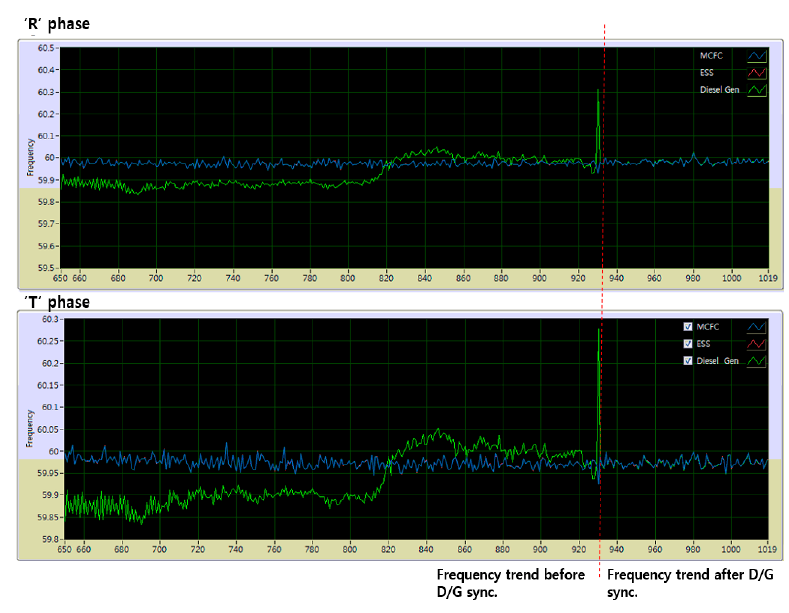
Figure 21. Frequency change when synchronizing diesel generators.